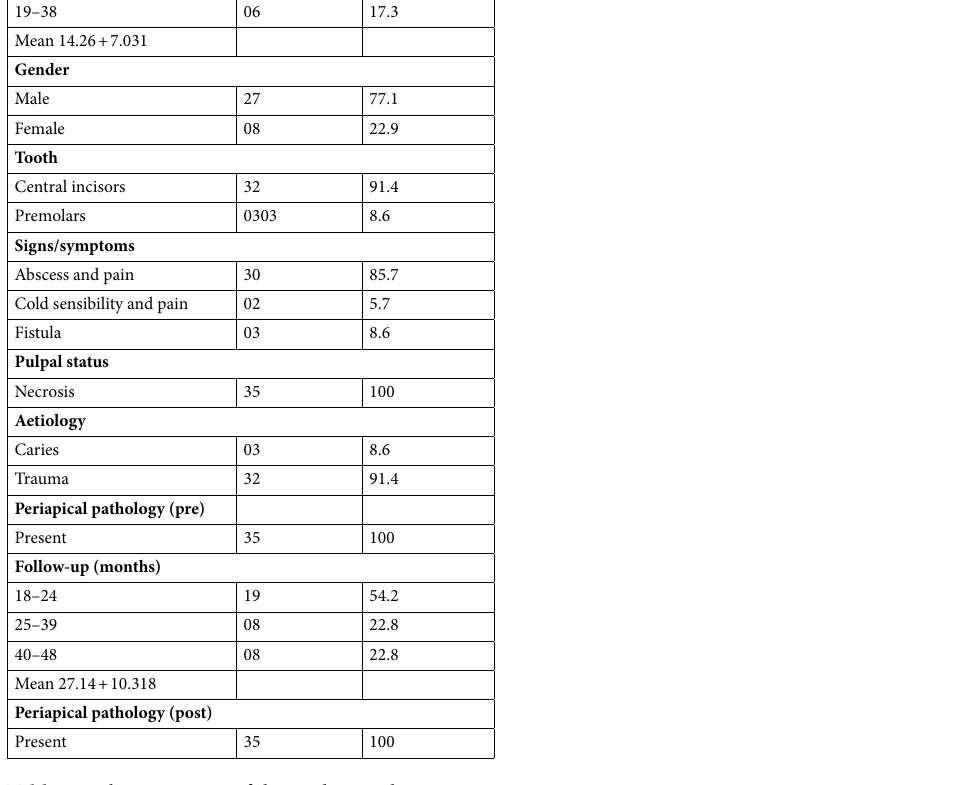
Table 2. Characteristics of the study